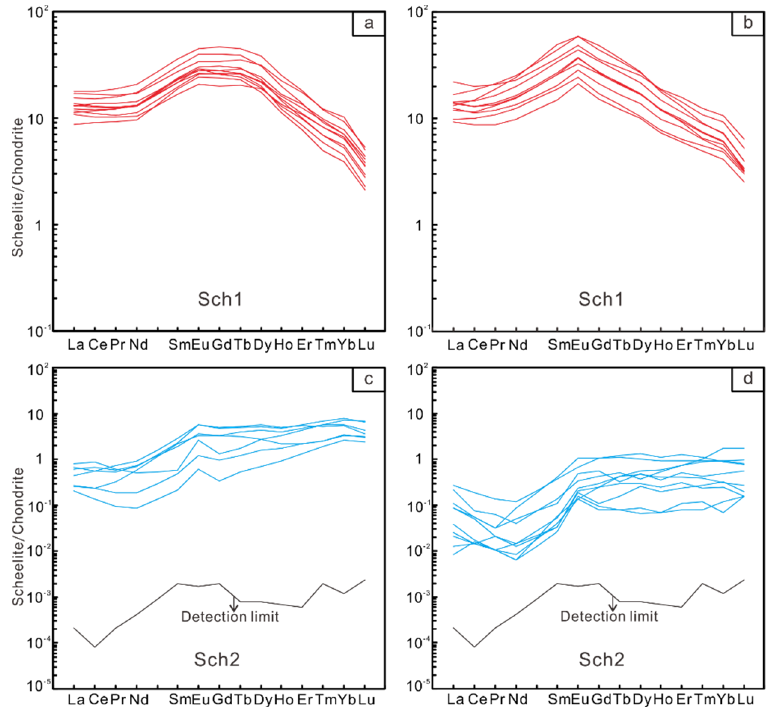
Figure 9. Chondrite-normalized REE patterns of scheelite from the Longshan Sb-Au deposit. ( a , b ) Sch1 samples; ( c , d ) Sch2 samples. The normalization values are from Sun and McDonough [57]. Sch1 and Sch2 have elevated Sr concentrations (2687 to 6318 ppm and 4525 to 11,040 ppm, respectively) and very low Na and Mo concentrations. The Na and Mo concentrations in Sch1 range from below detection limit (bdl) to 1.64 ppm and 0.004 to 0.017 ppm, respectively. The Na and Mo